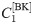
State transition diagram of the Markov model for the BKα channel. C1[BK]–C4[BK] are the closed states and O1[BK]–O4[BK] are the open states. Horizontal transitions represent voltage sensor movement while vertical transitions represent channel opening.